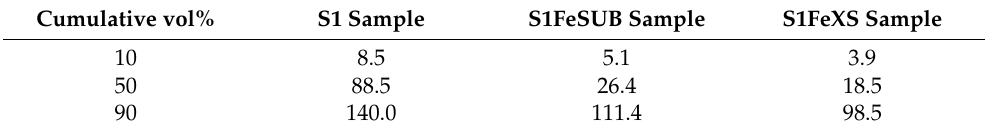
Table 1. Particle size distribution of S1, S1FeSUB and S1FeXS powders after calcination at 500 ◦ C. Cumulative